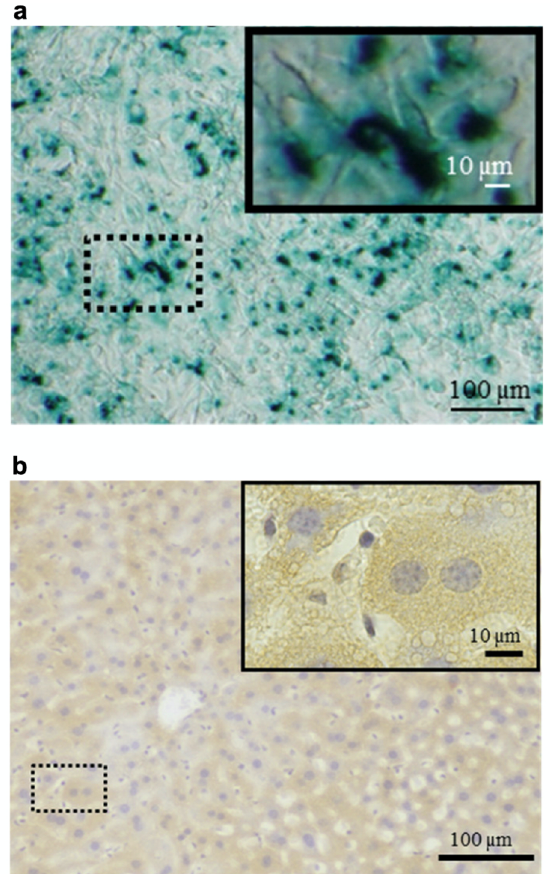
Figure 4. Protein delivery using heparin–protamine nanoparticles decorated with a cell-penetrating peptide. ( a ) In vitro delivery of β -galactosidase into cells. Blue cytoplasmic deposits indicate successful delivery. ( b ) In vivo delivery of β -galactosidase to mouse hepatocytes through hydrodynamics-based injection. Brown cytoplasmic deposits observed throughout the liver specimens indicate successful delivery. Adapted from ref. [36].